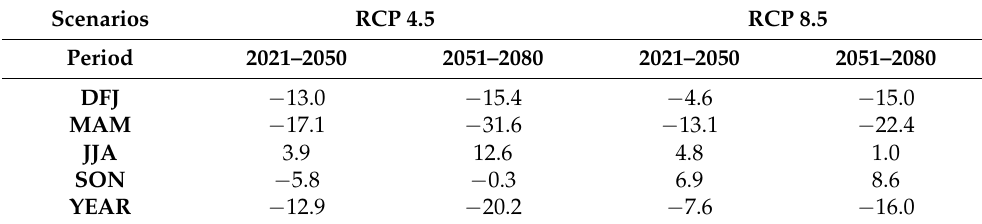
Table 3. Deviation (%) in the projected flow rate for Altamira relative to the 1981–2010 period.